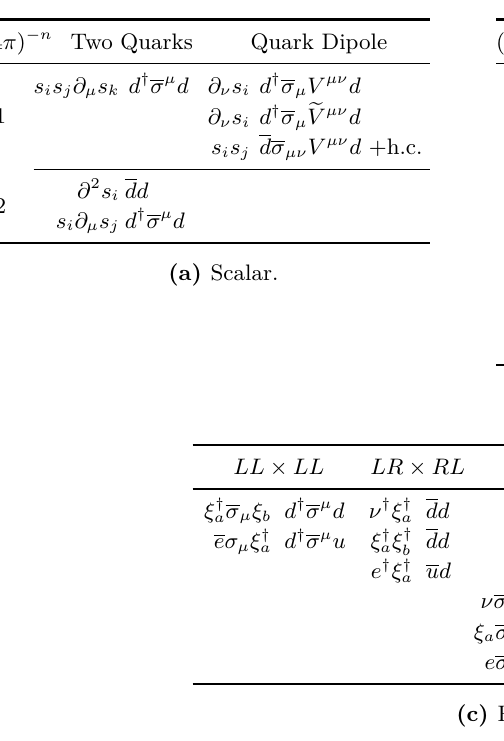
with V µν ∈ { F µν , G µν } are suppressed by factors of (4 π ) − 1 , and the operators